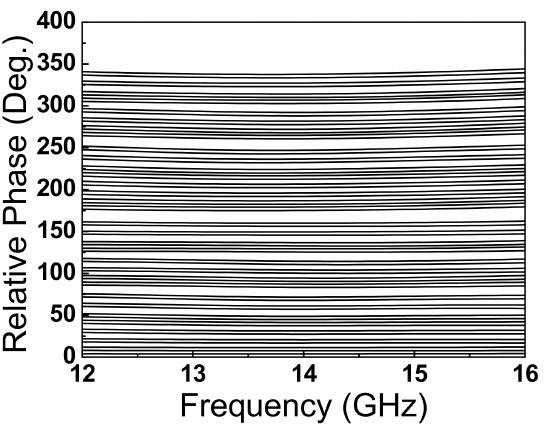
Figure 12. Measured phase characteristics of the Ku-band CMOS transmit and receive.